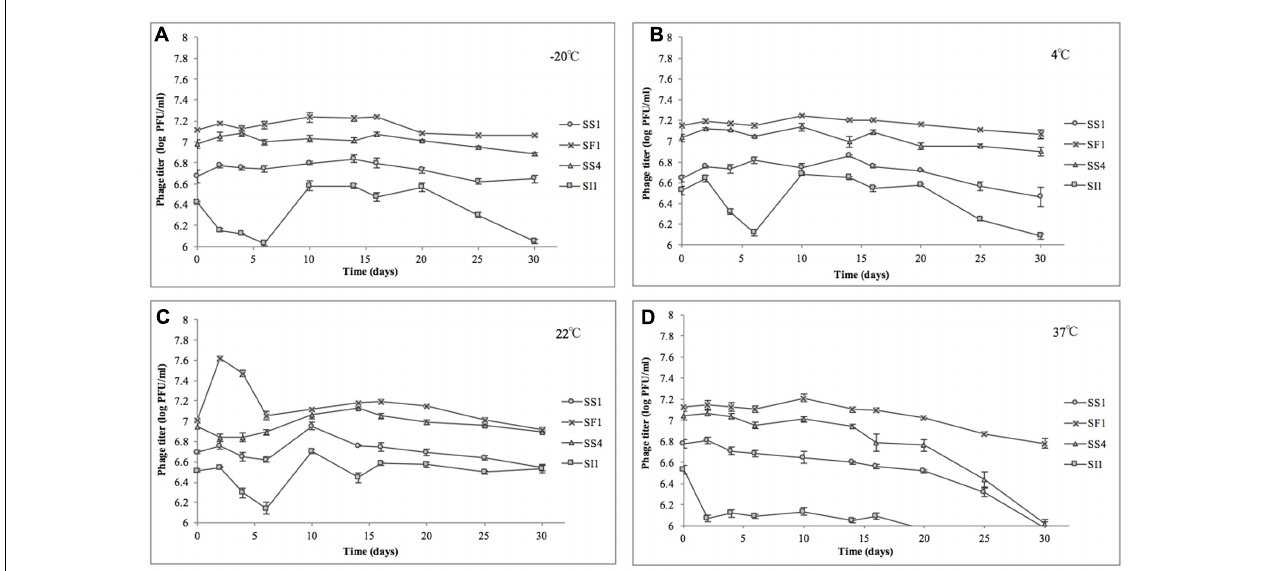
FIGURE 5 | Stability of phages SI1, SF1, SS1, and SS4 at (A) –20 ◦ C, (B) 4 ◦ C, (C) 22 ◦ C, and (D) 37 ◦ C over a period of 30 days. Data shown are the mean of three replicates ±